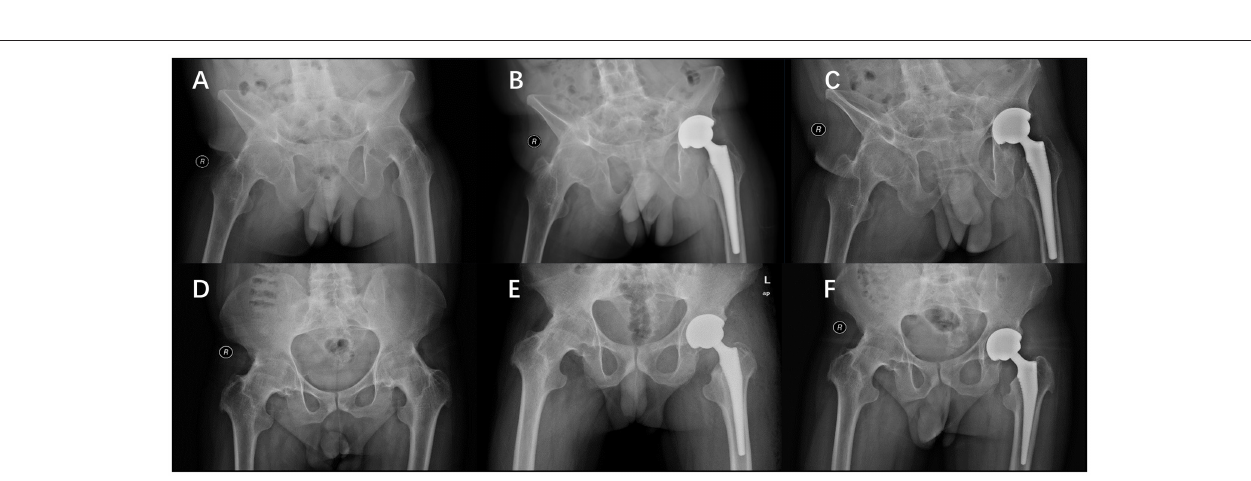
FIGURE 4 | Radiological outcomes of patients in two groups. (A) Number of cases with successful cup orientation. (B) Danoff safe zone.